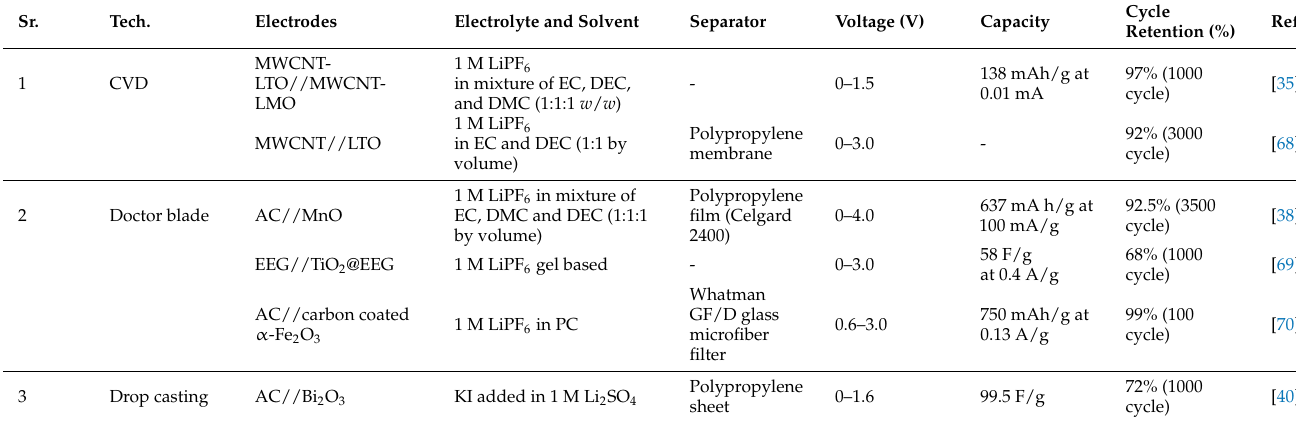
Table 2. Summary and examples of the electrode fabrication technology for Li ion-based energy storage